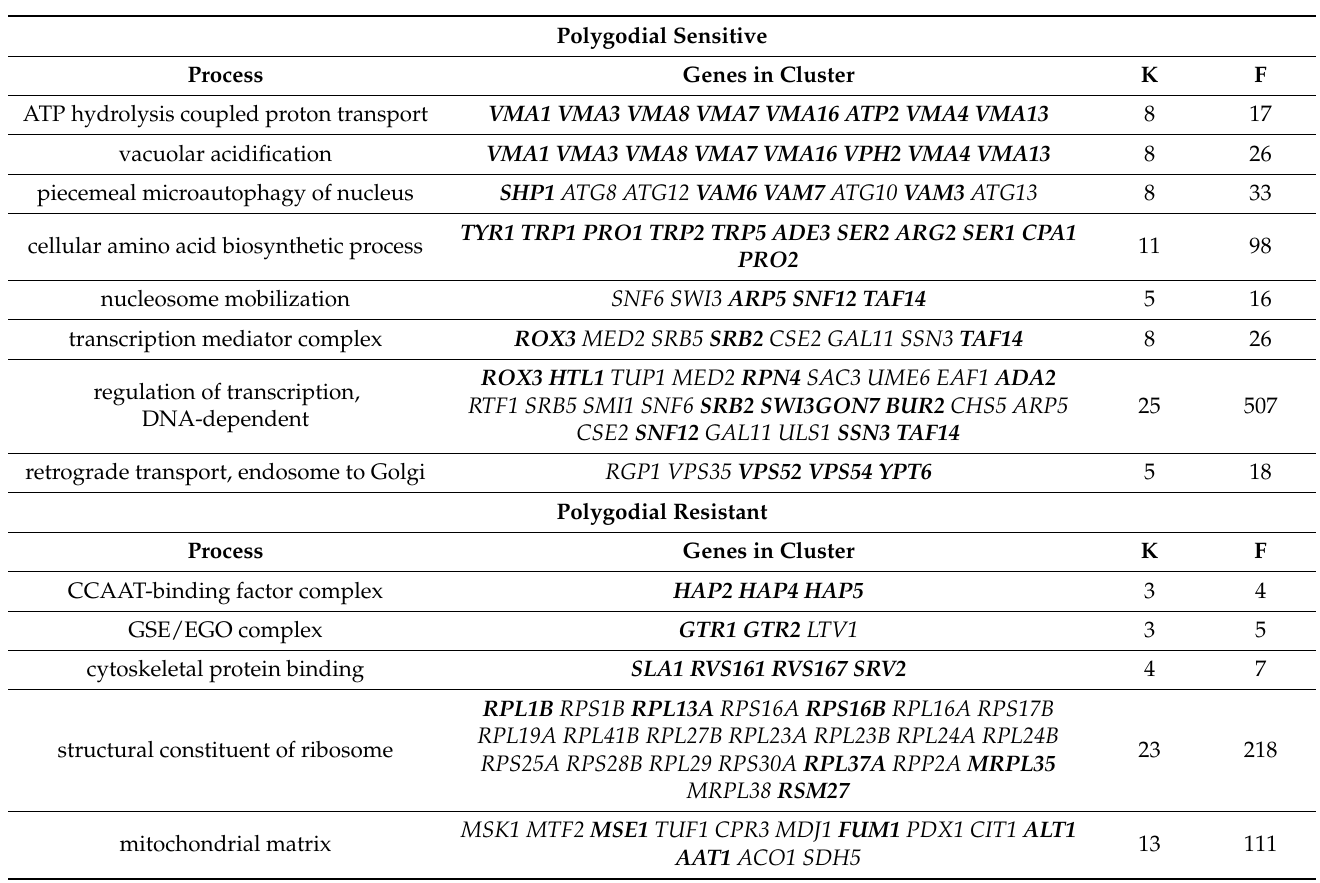
Table 1. Analysis of gene enrichment in the pools of polygodial sensitive and resistant strains based on the FunSpec software. Genes shown in bold correspond to hypersensitive or hyper-resistant strains. K denotes the number of genes from the input (sensitive or resistant strains) in a given GO category, while F refers to the total number of genes encoded by the yeast genome in a given GO